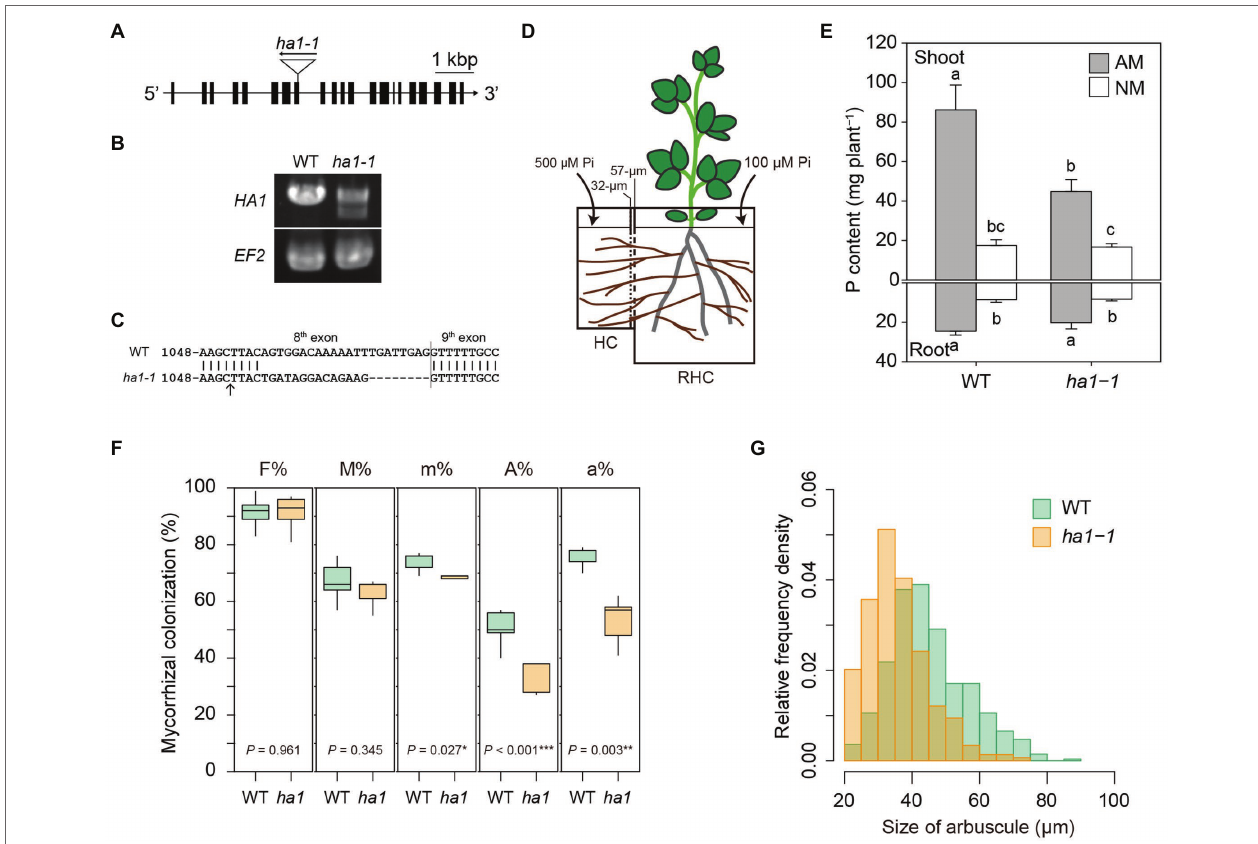
FIGURE 1 | Phenotype of the ha1-1 mutant cultivated in the two-compartment system. (A) Exon-intron structure of the HA1 gene, including the ha1-1 LORE1 insertion site. (B) RT-PCR analysis of HA1 in wild-type (WT) and ha1-1 roots colonized by Rhizophagus irregularis . The elongation factor 2 ( EF2 ) gene was amplified as the loading control. PCR was performed using 10 ng of cDNA as a template with 35 cycles. Similar results were obtained in three independent experiments. (C) Sequence comparison between WT and the ha1-1 HA1 cDNAs showing frameshift indels in the ha1-1 mutant transcript. The arrow indicates the LORE1 insertion site. (D) The two-compartment system: the root-hyphal (RHC) and hyphal (HC) compartments were separated by 32- and 57- μ M nylon meshes, allowing only hyphae of arbuscular mycorrhizal fungi to pass into the HC. The compartments were filled with autoclaved river sand. RHC was supplied with a half-strength Hoagland’s solution containing a low phosphate (Pi) concentration (100 μ M). HC was supplied with a nutrient solution with a high (500 μ M) concentration of phosphate. (E) P content in shoots and roots of arbuscular mycorrhizal (AM) and non-mycorrhizal (NM) plants 4 weeks after inoculation. Error bars show SE ( n = 5). For each plant part, bars topped by the same letter do not differ significantly at p < 0.05 on Tukey’s multiple comparisons test. (F) Arbuscular mycorrhizal fungal colonization in WT and ha1-1 roots. Mycorrhizal colonization was assessed according to method suggested by Trouvelot et al. (1986) after trypan blue staining. F%, frequency of mycorrhiza in the root system; M%, intensity of mycorrhizal colonization in the root system; m%, intensity of mycorrhizal colonization in the root fragments; A%, arbuscule abundance in the root system; and a%, arbuscule abundance in mycorrhizal parts of root fragments. The boxes show the first quartile, the median, and the third quartile; the whiskers reach 1.5 times the interquartile range ( n = 5). p -values are based on Student’s t -tests (*, p < 0.05; *, p < 0.01; **, p < 0.001). (G) Relative frequency density of arbuscule size. The lengths of the major axis of 549 WT and 297 ha1-1 arbuscules randomly selected from >20 μ M- long arbuscules stained with wheat germ agglutinin conjugated with Oregon Green 488 were measured. According to the two-sample Kolmogorov–Smirnov test, the size distribution was significantly different between the plant genotypes ( p <